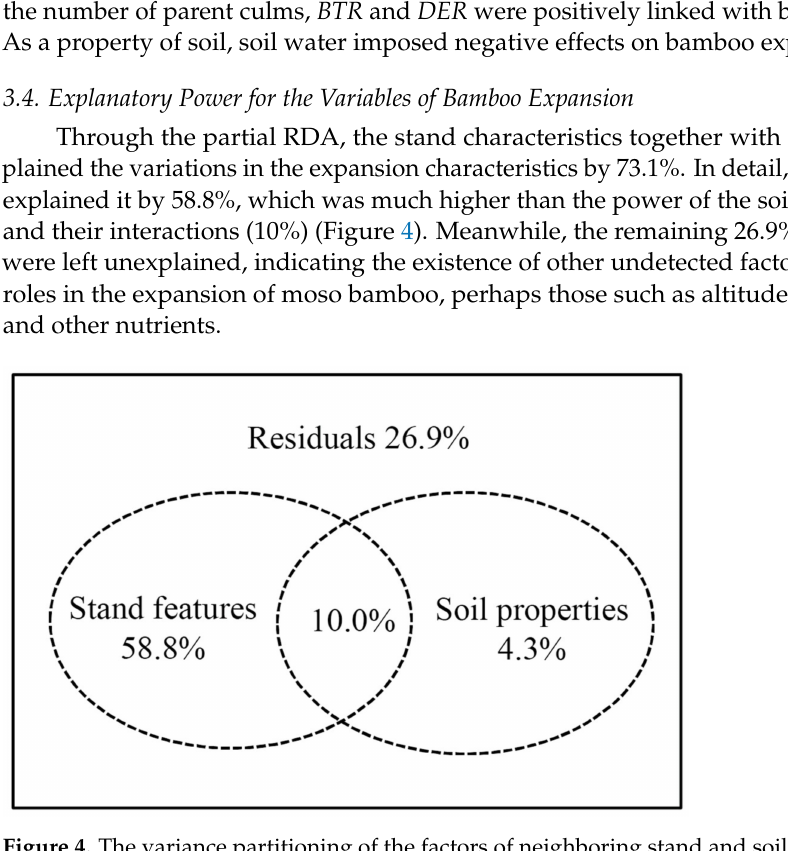
Figure 4. The variance partitioning of the factors of neighboring stand and soil in explaining moso bamboo